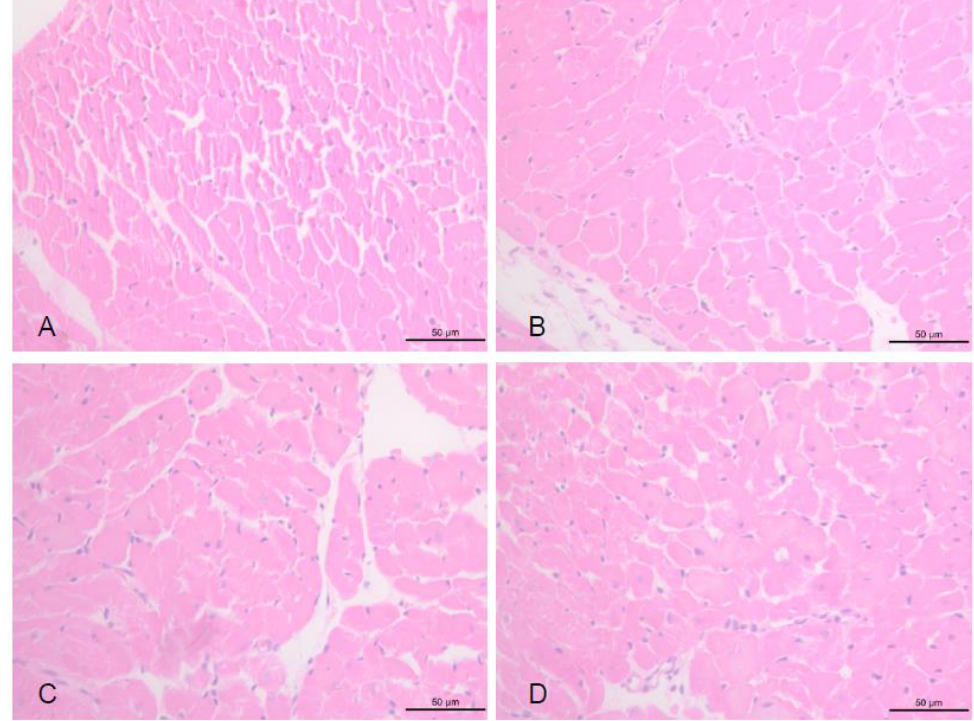
Figure 1. Myocyte Cross-Sectional Area. ( A ) control animals; ( B ) infarcted animals; ( C ) infarcted animals supplemented with jaboticaba 2%; ( D ) infarcted animals supplemented with jaboticaba 4%. The percentage of collagen was higher in all infarcted groups than in the C group (Figure 2). However, the IJ2 group had less fibrosis than groups I and IJ4 (C = 2.81 ± 0.87%, I = 7.82 ± 0.55% *, IJ2 = 5.82 ± 0.17%, IJ4 = 7.69 ± 0.15% *; * p < 0.05 versus C and IJ2) .